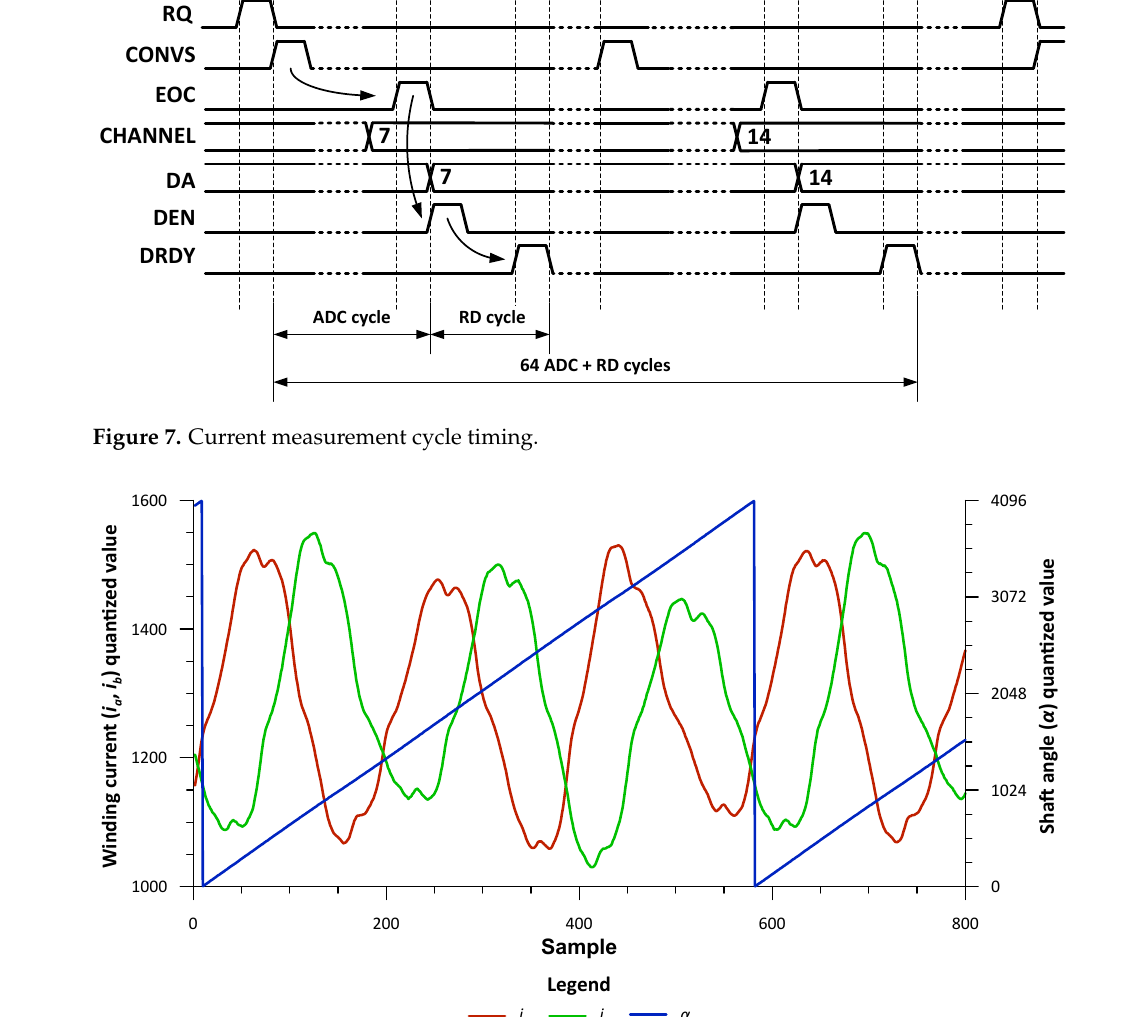
Figure 8. Windings current captured by XADC using inverter period averaging and shaft angle acquired from MAB sensor.